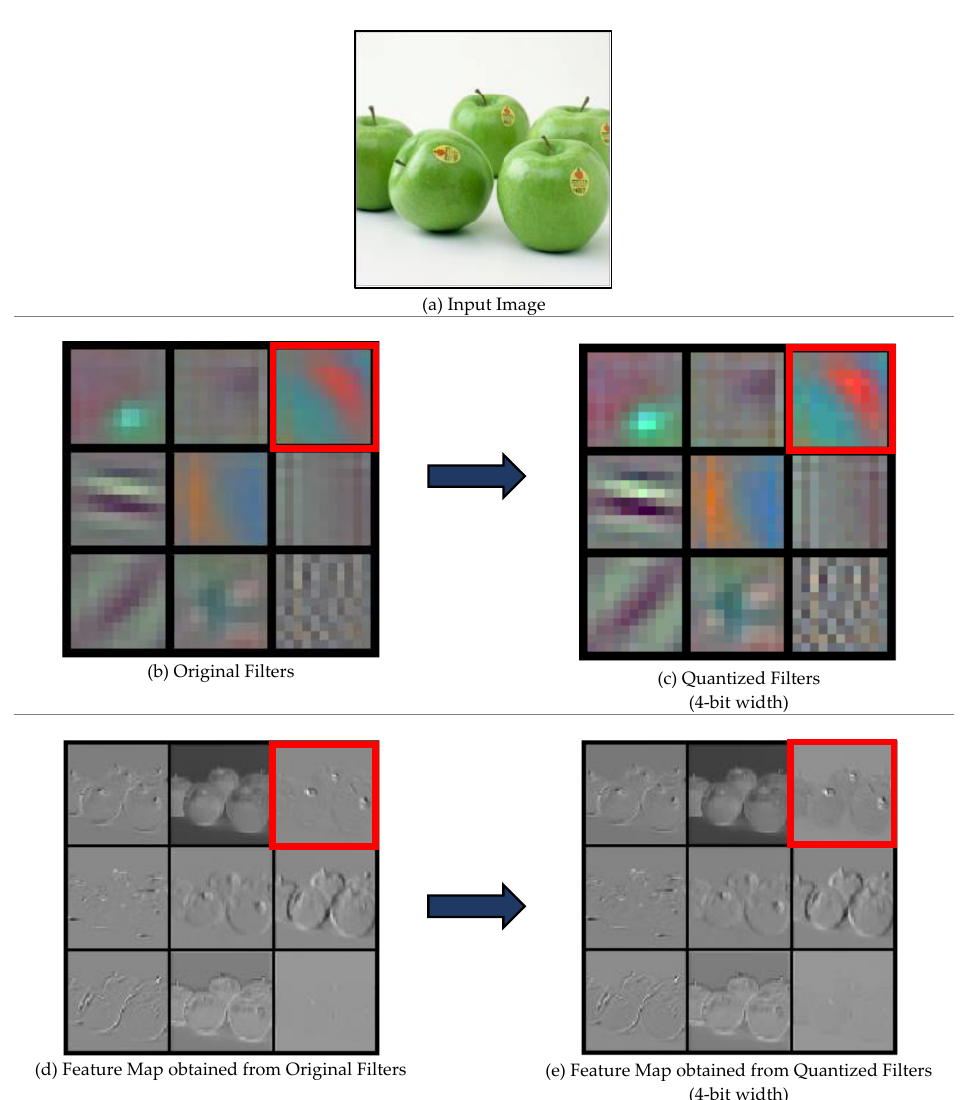
Figure 4. Visualization of quantized filters and feature maps.